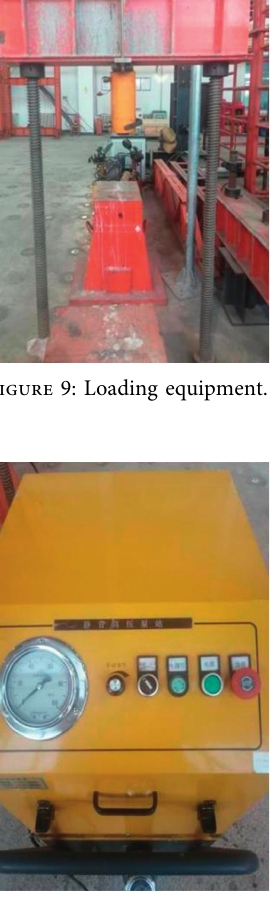
Figure 10: Silent high-pressure testing machine.